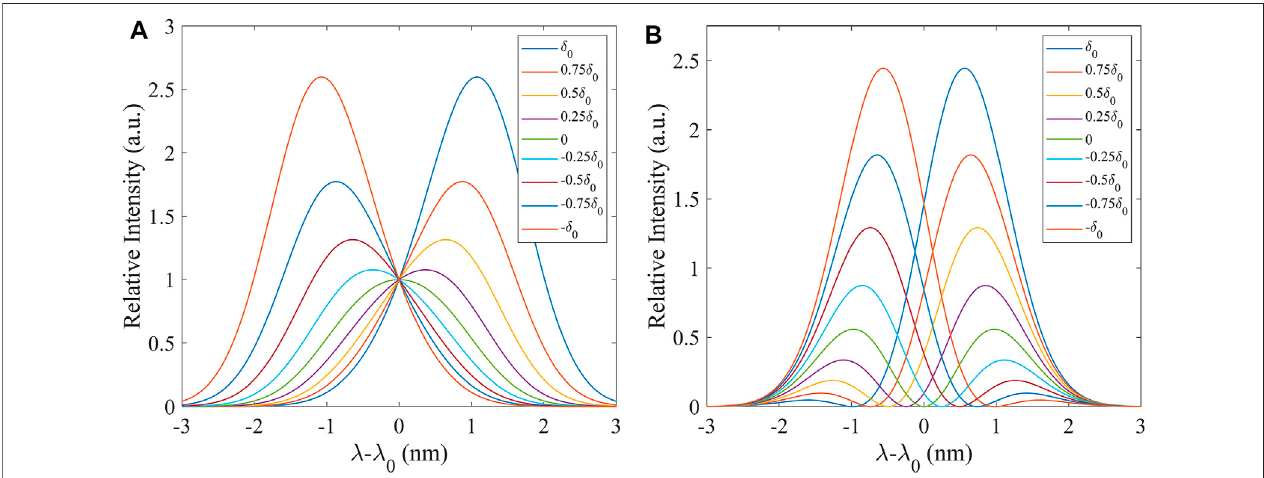
FIGURE 1 | Theoretical spectra of the different phase differences under the enforcement of weak measurement conditions. The spectrum with different colors represents the various phase differences in the light path. (A) The α ≠ β ideal case is described in AAV theory. (B) α (cid:1) β or α is often close to β .